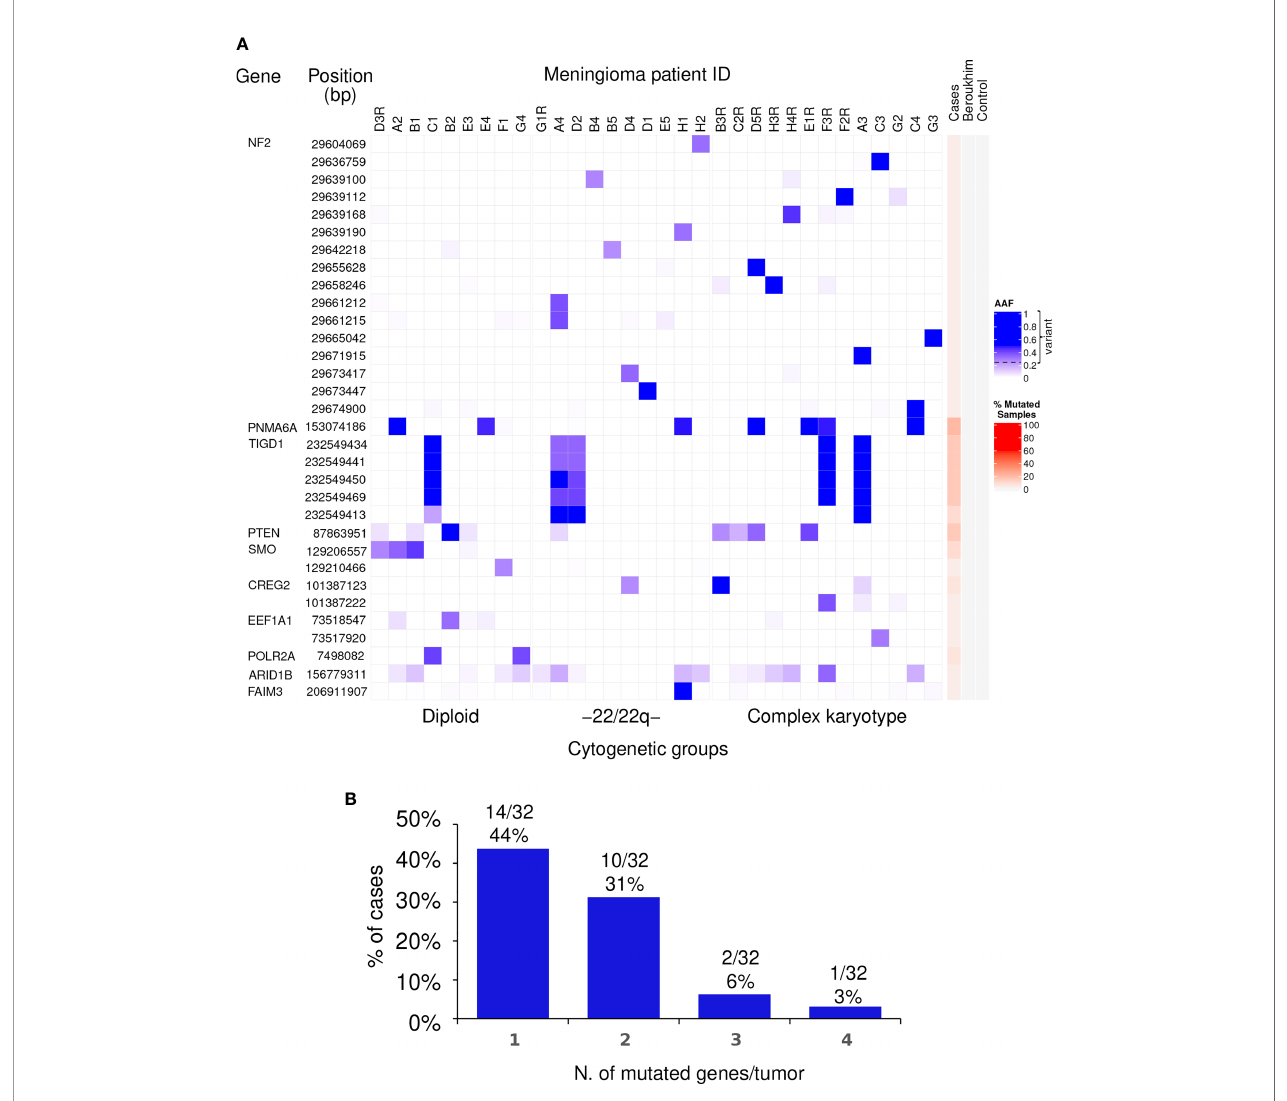
FIGURE 1 | Distribution of non-synonymous genetic variants found altered in WHO grade 1 meningiomas. (A) Heat map of the non-synonymous genetic variants identi fi ed (rows) in individual WHO grade 1 meningiomas (columns) classi fi ed according to their chromosomal copy number cytogenetic pro fi le. For each genetic variant, alternative allele frequencies (AAF) are color coded in blue from the lowest (light blue) to the highest (dark blue) percent values using the 0.25 AAF value as the cutoff for variant detection. Patients that showed tumor recurrence are identi fi ed on top of each column by the patient ID code followed or not by the letter “ R ” for the recurrent vs non-recurrent tumors. The red color scale represents the overall percentage of mutated samples among the WHO grade 1 meningiomas studied in our cohort as well in the controls. (B) The number and frequency of tumors carrying non-synonymous genetic variants in different (numbers of) genes are